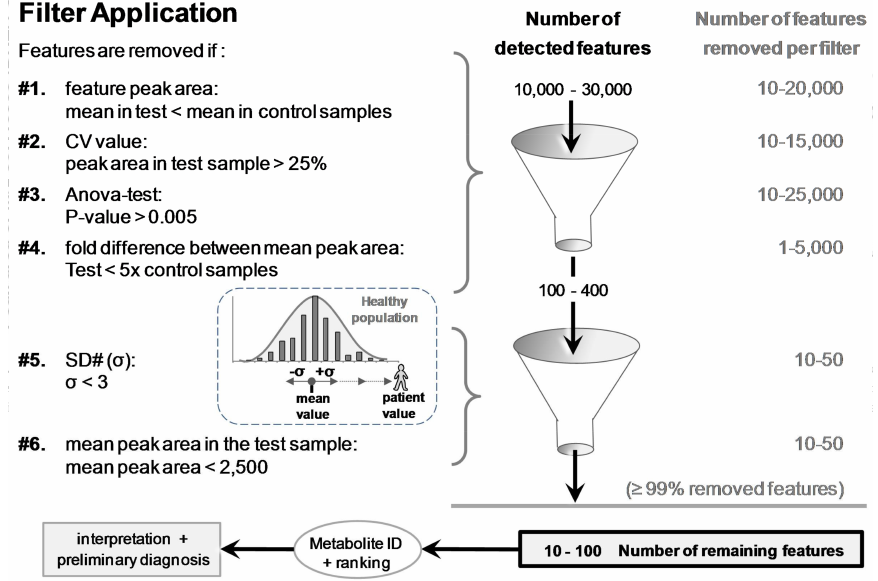
Figure 4. The six filters used to discard ≥ 99% of the >10,000 detected features. Remaining features were eventually ranked based on SD# and mean peak area values prior to putative identifications and biomedical interpretations. SD# value was calculated with the following equation: SD# of feature f = [(|peak area f mean in test sample − peak area f mean in control group|)/(SD of control group)]. It corresponds to the distance, as a number of [ σ ] (=SD#), between the peak area mean of the test and the peak area mean of the control samples (e.g., samples of a patient and a healthy